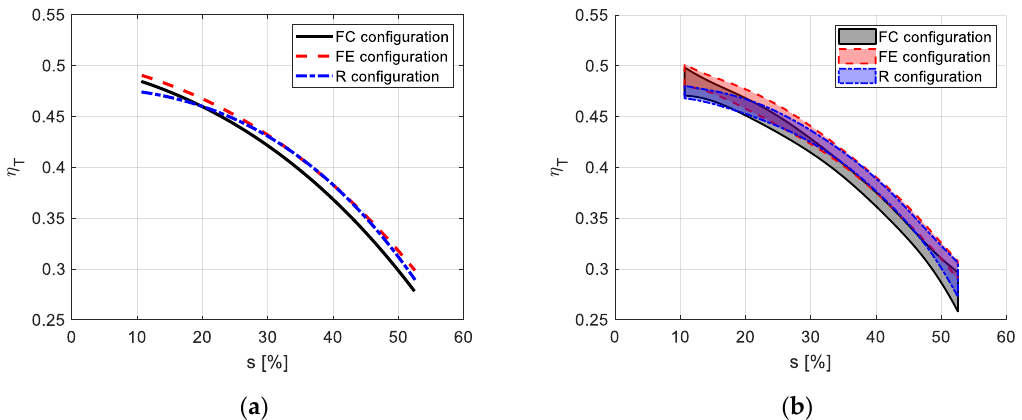
Figure 8. ( a ) NTR-s regression curves and ( b ) prediction bound areas for tractor configurations FE, FC and R. Regression coefficients are listed in Table 8. The lower and upper slip values for the models are 11 and 52%, respectively. Table 9. Coefficient values for the NTR-η T regression model (R3).